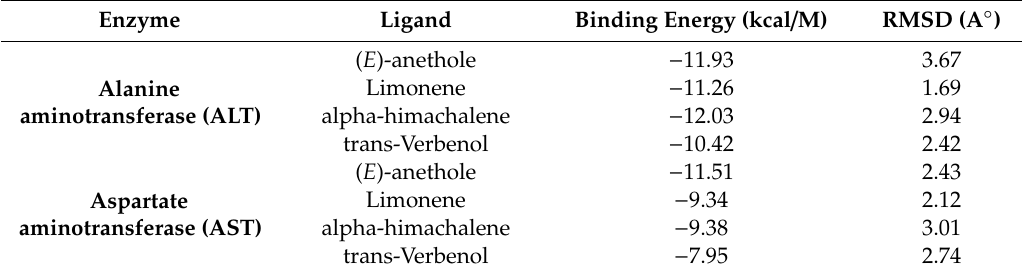
aminotransferase